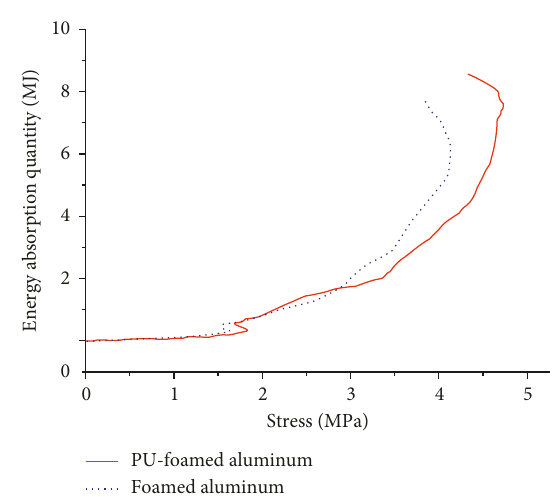
Figure 26: Energy absorption-stress curve.